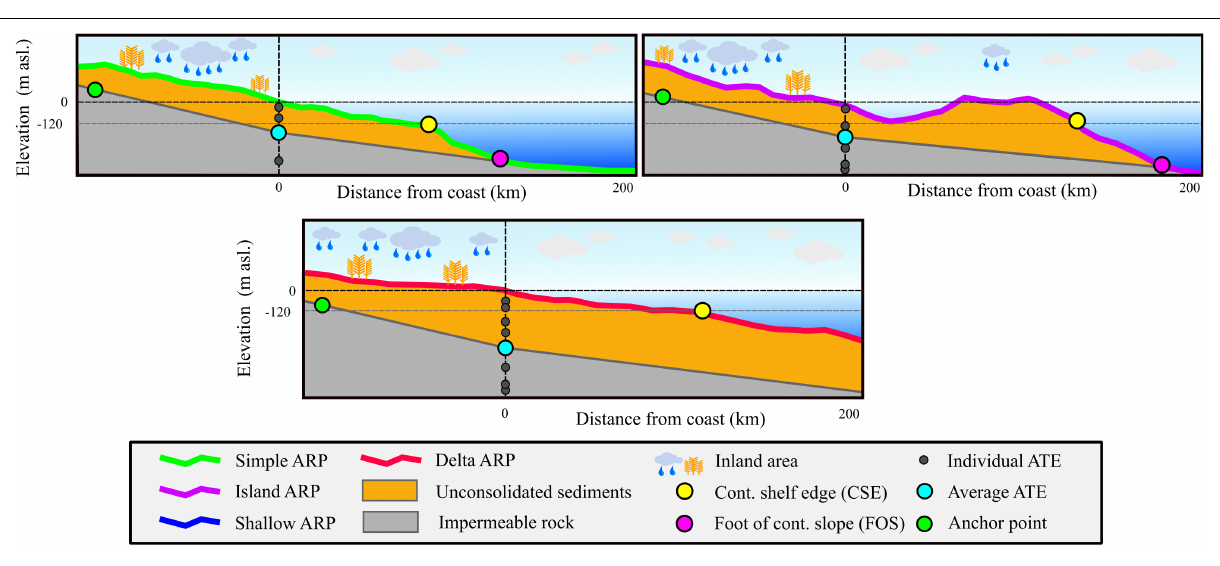
the fining upward sequence that is typically observed toward the top of low stand fluvial depositional systems (e.g., Bridge, 2009; Miall, 2014) and at the base of transgressive to high sea- level stand coastal deposits (e.g., Cattaneo and Steel,